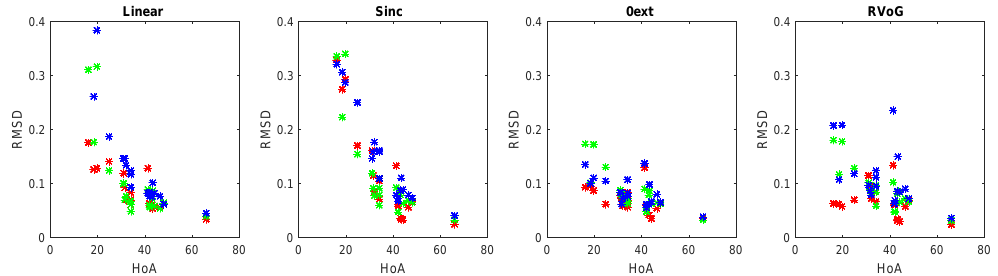
Figure 7. Dependence of RMSD of coherence model fit on HoA. Red marks denote pine, green spruce and blue deciduous